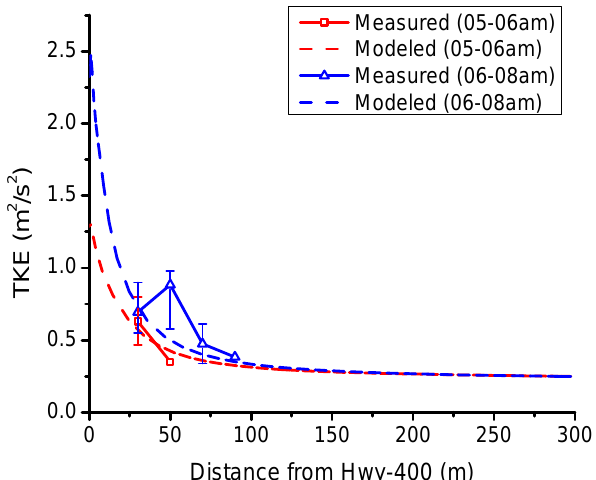
Figure 3. Comparison of the TKE from the FEVER observations at a roadside tower and model simulations for morning rush hour: Fig. 3. Comparison of the TKE from the FEVER observations at a roadside tower and 2 05:00–06:00 (red) and 06:00–08:00LT (blue) (measurements in im- age referred to in a.m.). Measurement data are plotted as solid lines model simulations for morning rush hours: 05:00-06:00 (red) and 06:00-08:00 a.m. 3 and model simulation results are plotted as dashed lines. The error bars represent 25th to 75th (blue). Measurement data are plotted in solid lines and model simulation results are 4 plotted in dashed lines. The error bars on top of measurement data represent 25 th to 75 th 5 percentiles. 6